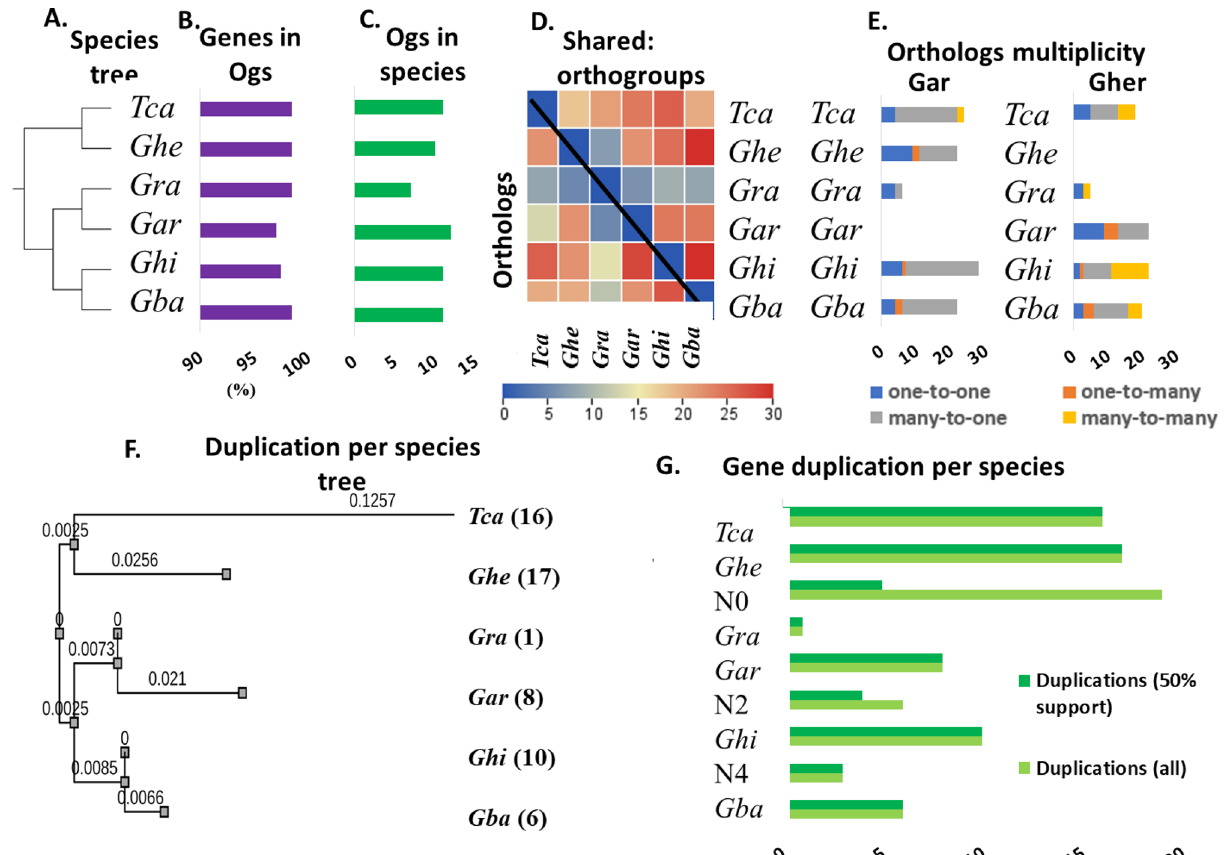
Figure 6. Summary of evolutionary analysis of Zf-BED s in Gossypium sp. ( A ) Species-based phylogenetic tree, ( B ) percentage of genes in orthogroups, ( C ) number of species-specific orthogroups, ( D ) heatmap of orthologs statistics one-to-one, ( E ) Heatmap of orthologs statistics